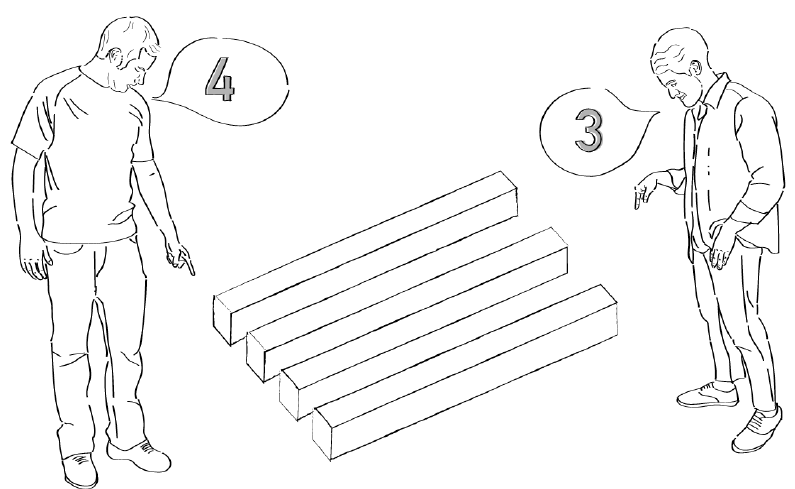
Figure 1. Illustration of two experts having different points of view in regards to a specific phenomenon.